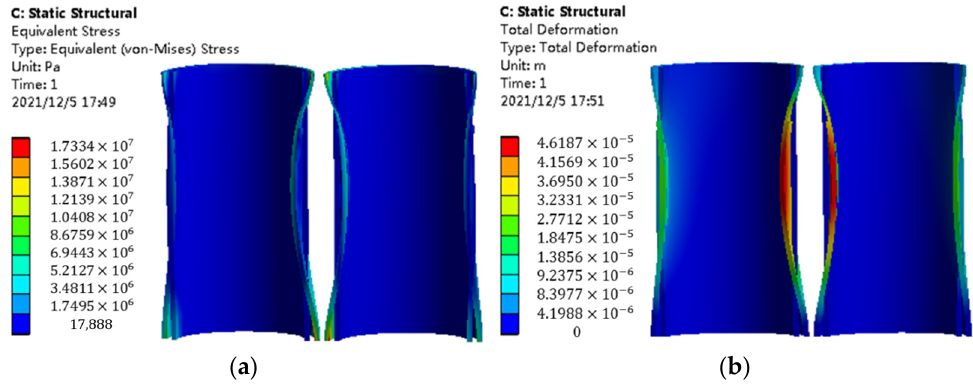
Figure 16. Primary windings cloud map: ( a ) stress cloud map; ( b ) displacement cloud map. The axial force is due to the radial magnetic field. The maximum stress of the winding reaches up to 1.7334 × 10 7 Pa under the excitation of the inrush current, as can be seen from winding, with a maximum deformation of 4.6187 × 10 − 2 mm. Based on Figure 7, the anal- ysis of the impact of the axial force Fa on the deformation of the winding, combined with